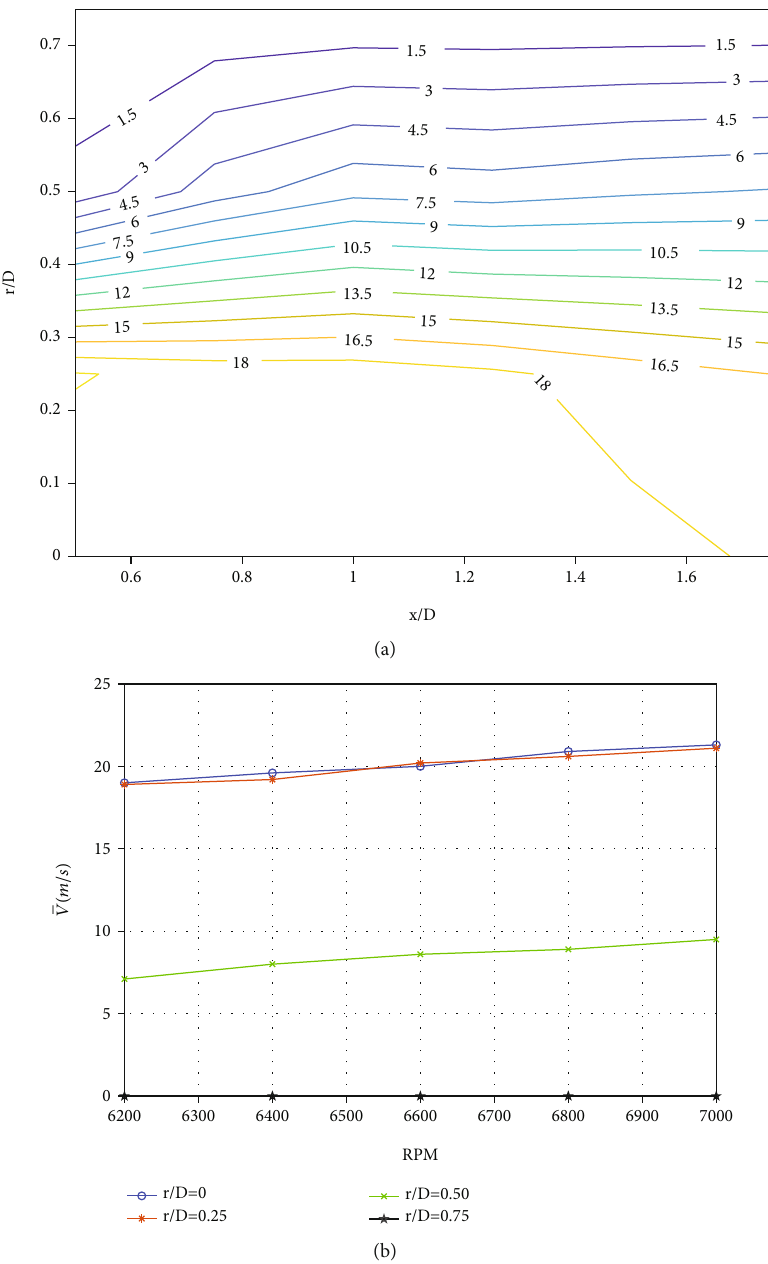
Figure 8: Time-averaged slip- fl ow speed distribution of APC propeller 1485. (a) Time-averaged slip- fl ow speed distribution of APC propeller 1485 at RPM = 6200 . (b) Time-averaged slip- fl ow speed of APC propeller 1485 as a function of RPM at x / D = 1